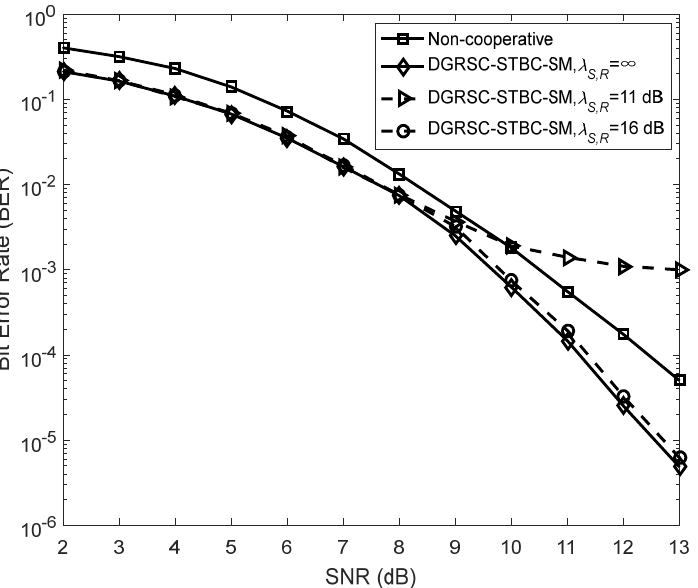
Figure 8. Comparisons between DGRSC − STBC − SM with C S ( 25, 19, 7 ) and C R ( 25, 10, 16 ) and non − cooperative counterpart under Algorithm 2 , N t = 3, N r = 4 and 4 −